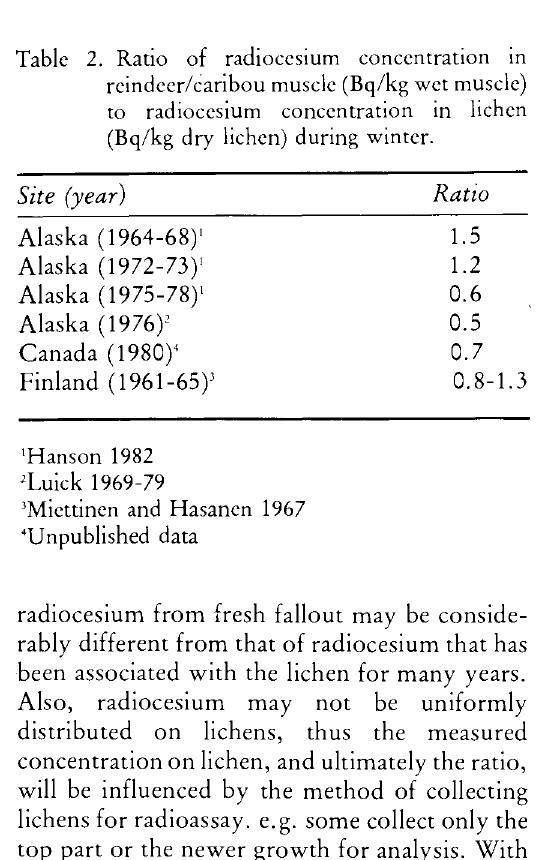
Table 2. Ratio of radiocesium concentration in reindeer/caribou muscle (Bq/kg wet muscle) to radiocesium concentration in lichen (Bq/kg dry lichen) during winter.